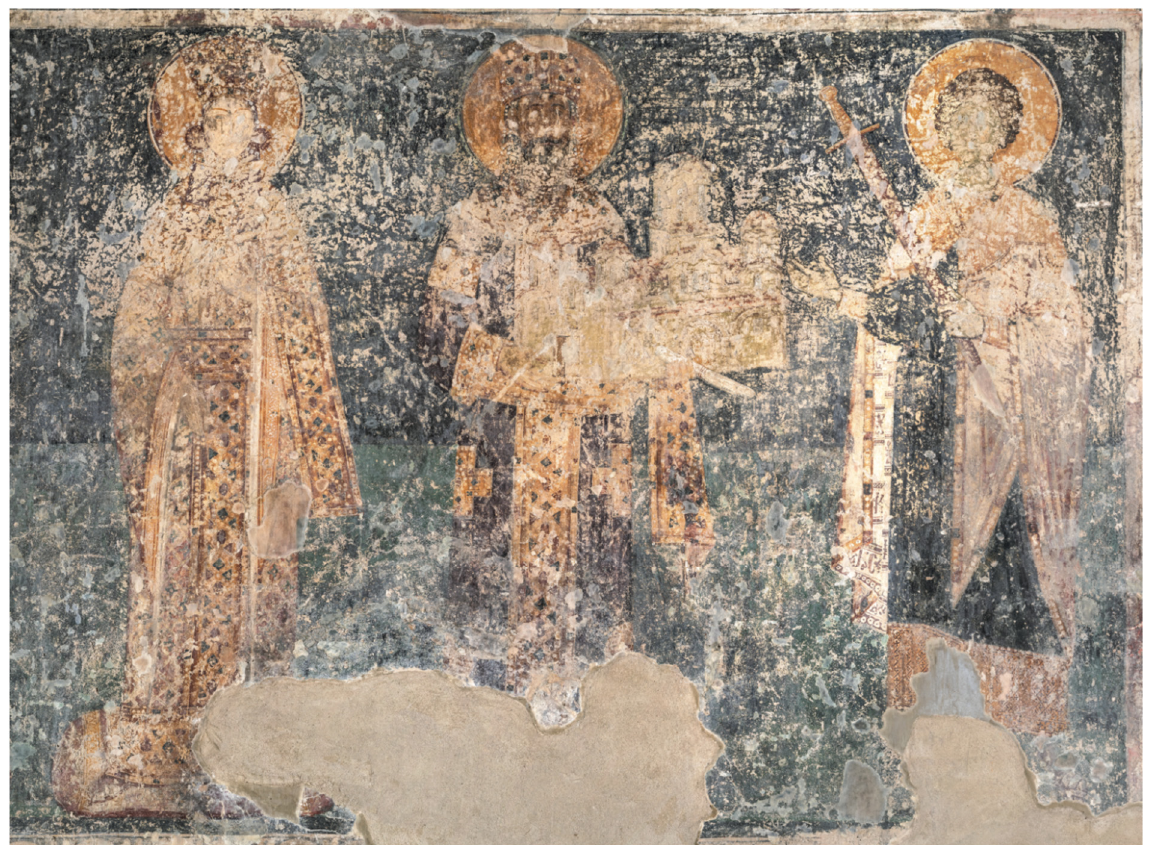
Figure 3. King Milutin with the church, fresco, 1317–1318. Church of St. George Tropaioforos, Monastery of Staro Na- gori č ino, north wall of the narthex. Photo Bojan Popovi ć